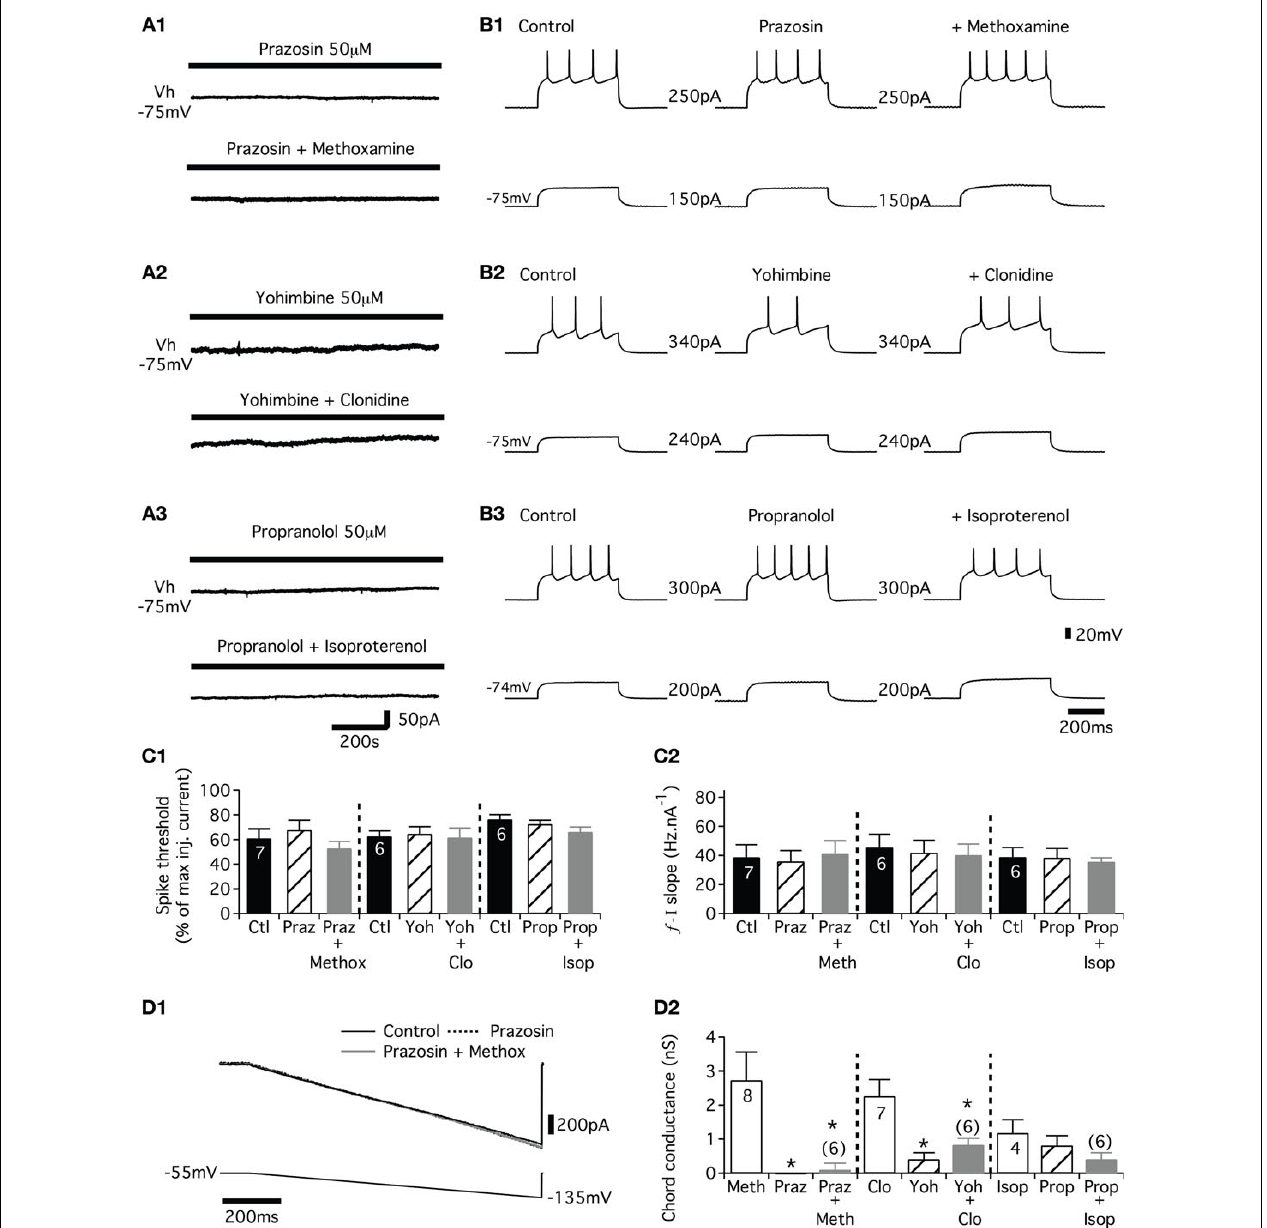
FIGURE 5 | Effects of adrenoreceptor antagonists on adrenoreceptor (Ctl, black bars). (C2) Summary histograms of the slopes of the frequency agonist-induced changes in membrane properties. (A) Representative current (f–I) relationship in control (fi lled bars), in the presence of the traces showing the effects of different noradrenergic antagonists ( α prazosin; antagonists (hatched bars) and during co-applications of the antagonist and 1 α yohimbine; β propranolol) alone or in combination with their corresponding agonist (grey bars) (D) . I–V relationships obtained during voltage ramps in 2 agonist ( α methoxamine; α clonidine; β isoproterenol) on the current control conditions (black line), in the presence of prazosin (dashed line) and in 1 2 recorded from motoneurons held at − 75 mV (Vh). (B) Representative traces the presence of both prazosin and methoxamine (grey line) (D1) . The current showing the spike frequency and the threshold for spike generation during modulated by the noradrenergic antagonists was isolated by subtracting the depolarizing current pulses (current value between the traces) in the presence current seen in the I–V relationship in the presence of the antagonist from that of the antagonists alone or the antagonist–agonist combinations (C) . (C1) Plot in control condition. Similarly, the current modulated by the antagonist–agonist of the spike threshold (computed as the percentage of the maximum injected combinations was isolated by subtracting the current of the I–V relationship in current needed to evoke spiking) in the presence of the three different the presence of both antagonist and agonist from that in the presence of the antagonists (hatched bars; prazosin: Praz, yohimbine: Yoh and propranolol: antagonist alone. (D2) Summary histograms of the chord conductance of the Prop) and in the presence of the antagonist–agonist combinations (grey bars; current extracted from voltage ramps in the presence of the agonist alone prazosin plus methoxamine: Praz + Meth, yohimbine plus clonidine: Yoh + Clo (open bars), the antagonist alone (hatched bars), and in the presence of both and propranolol plus isoproterenol: Prop + Iso) compared to control condition antagonist and agonist (grey